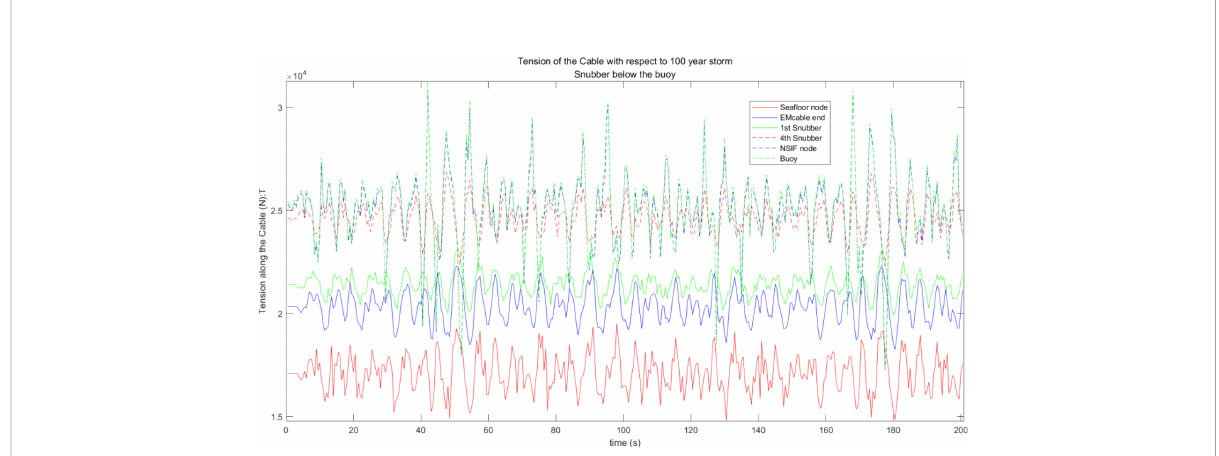
FIGURE 9 Dynamic tension for various components for a Nilspin cable with the snubber up.